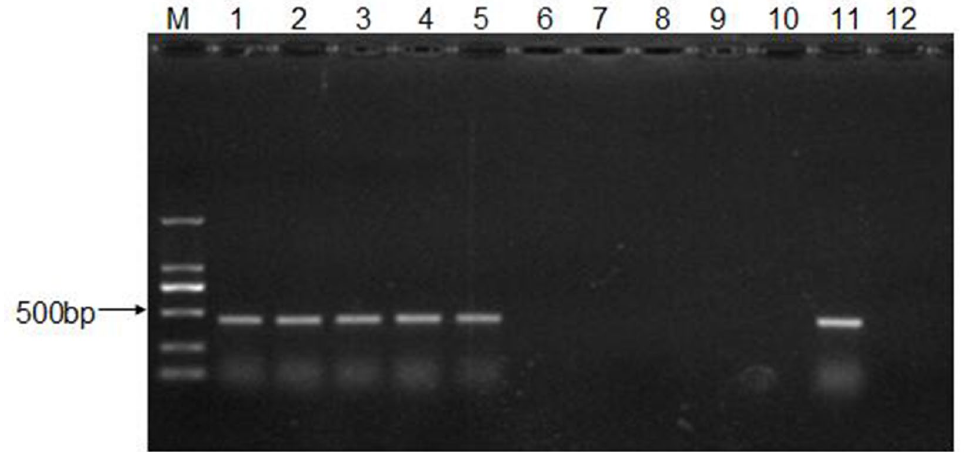
Figure 2. Determination of CEV-JL14 infective routes. Three-day-old ICR suckling mice in experimental groups were injected with 2 × 10 8 TCID 50 of CEV-JL14 virus by intraperitoneal injection, intramuscular injection, subcutaneous injection, oral administration, and intranasal administration. CEV-JL14 was detected in suckling mice inoculated with CEV-JL14 via all infective routes (Lane 1–5). No fragments were detected in control groups (Lane 6–10). Lane 1: intraperitoneal injection; Lane 2: intramuscular injection; Lane 3: subcutaneous injection; Lane 4: oral administration; Lane 5: intranasal administration. Lane 11 and Lane 12 were positive and negative control, respectively. M stands for the DNA ladder.